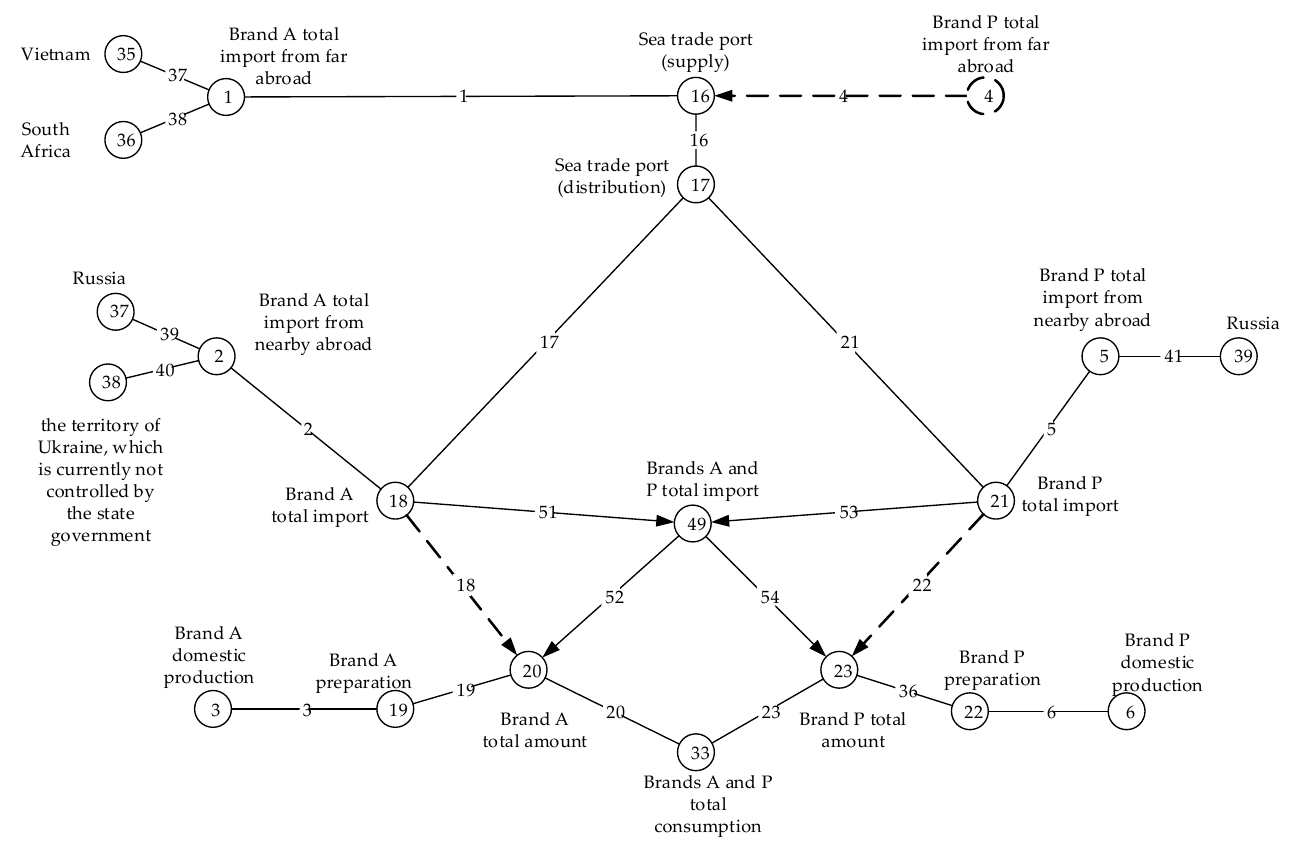
Figure 3. Anthracite supply subsystem [82], (p. 99).